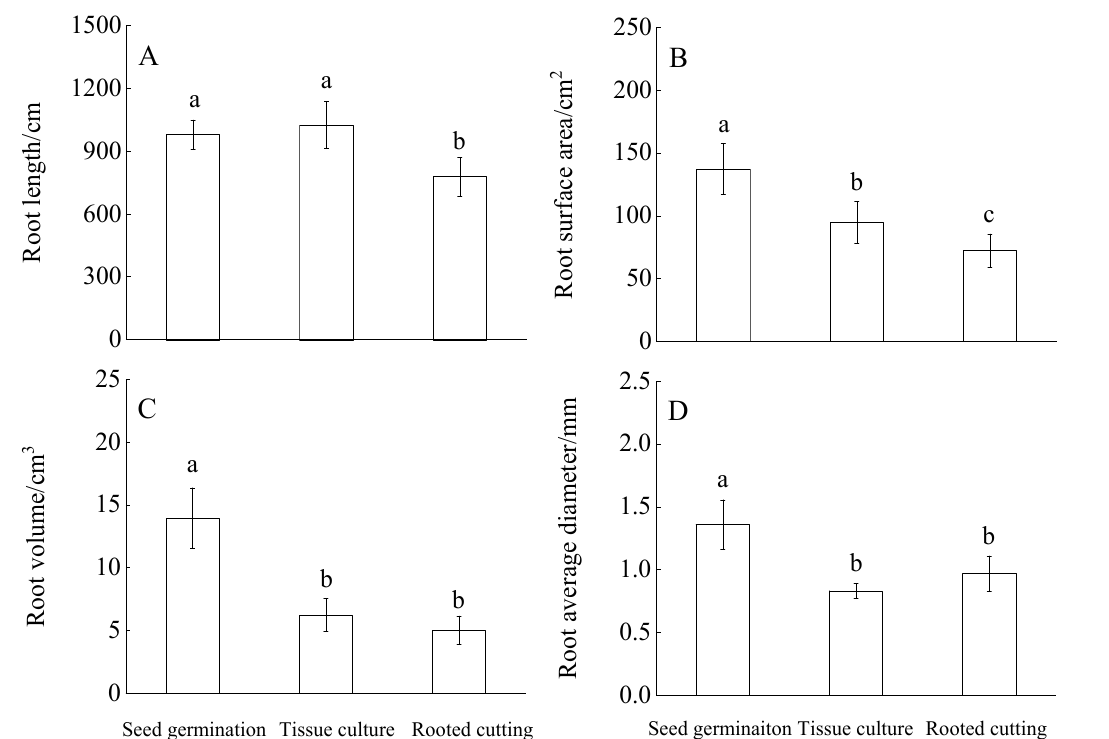
Figure 1. Differences in the root length ( A ), root surface area ( B ), root volume ( C ), and root-average diameter ( D ) among different propagation methods. Bars (mean ± standard error) and the different lowercase letters indicate significant differences among different propagation methods at p < 0.05.